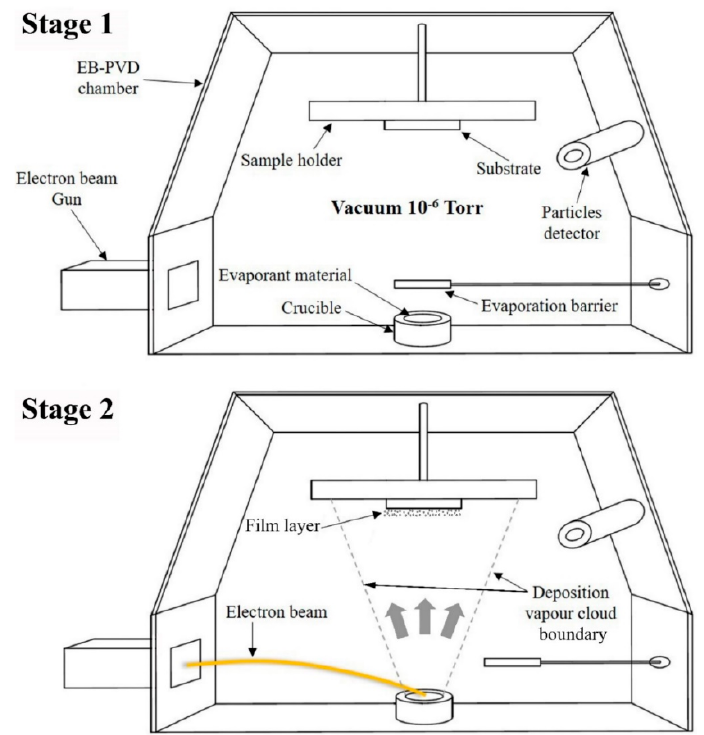
Figure 3. Schematic of electron beam physical vapor deposition (EB-PVD) equipment (Stage 1) and the generation of the film for coating